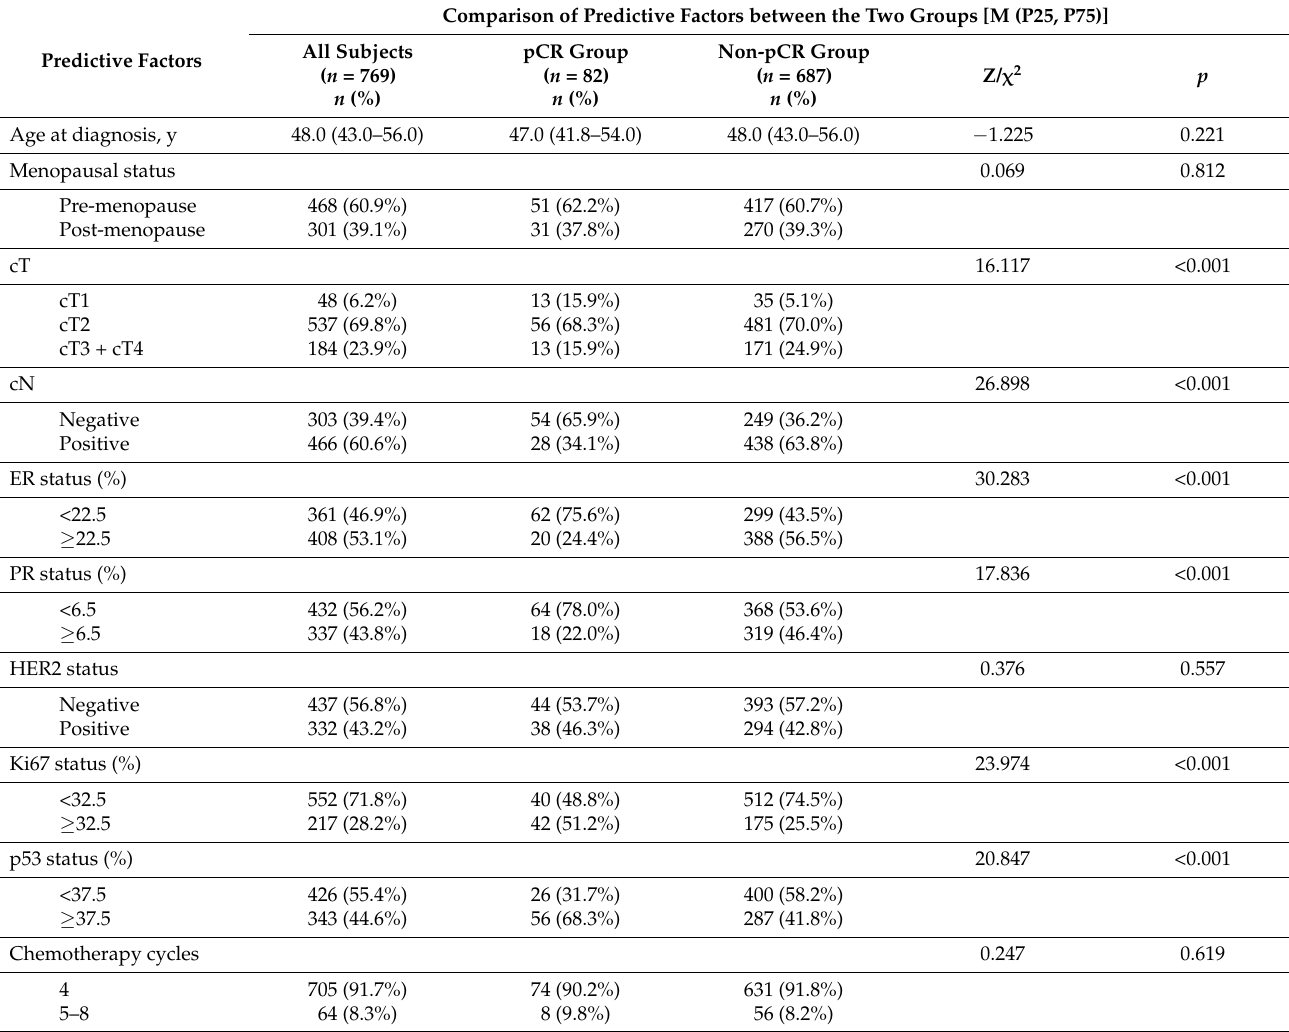
Table 1. Baseline clinicopathological characteristics in the primary cohort and univariate analysis.